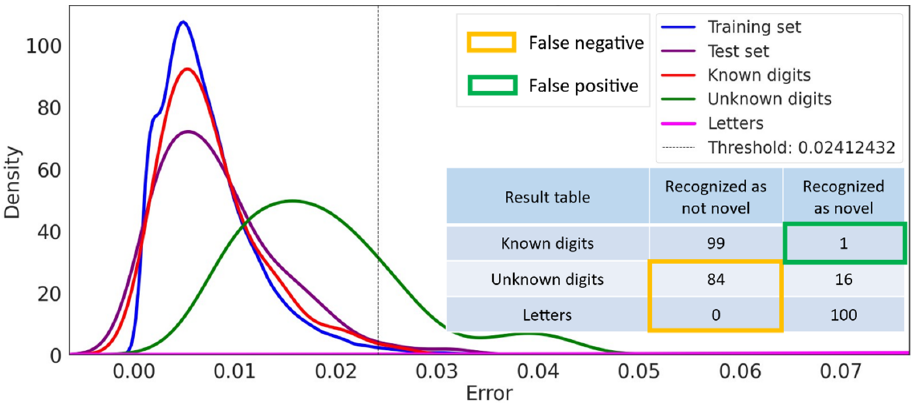
Figure 7. Performance of “naive” autoencoder-based novelty detection.